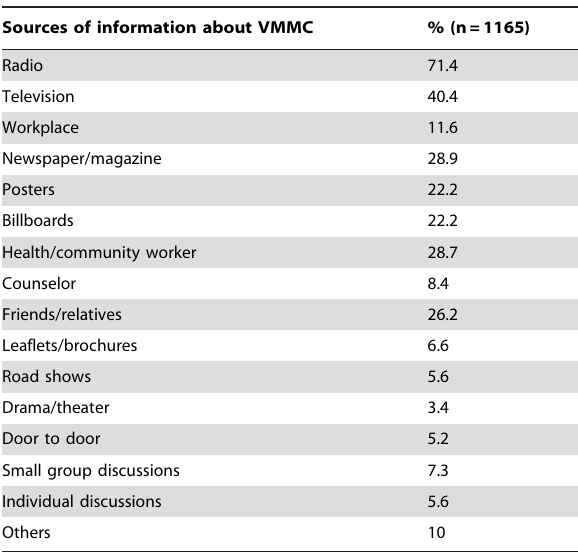
Table 3. Sources of information about VMMC among males aged